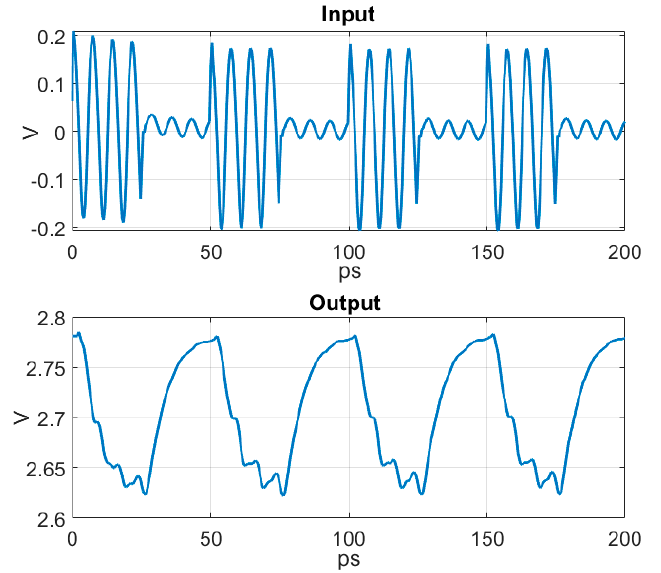
Figure 12. Time domain simulated input and corresponding output from the PD. The carrier frequency is 140 GHz.